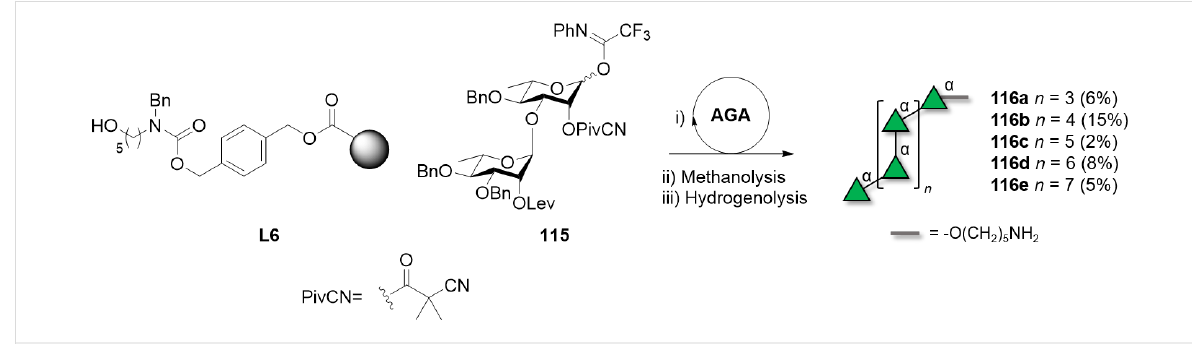
Scheme 17: AGA of type I rhamnans up to 16mer using disaccharide BB 115 and CNPiv PG. The AGA cycle includes coupling (TfOH) and Lev deprotection